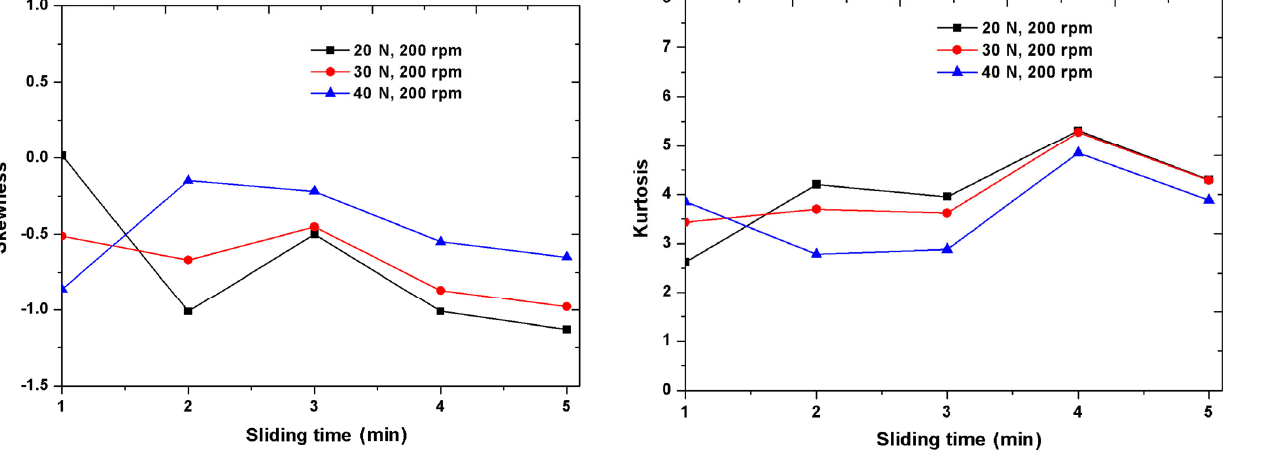
Fig. 17 Variation of S sk with sliding time for the same speed and different loads.